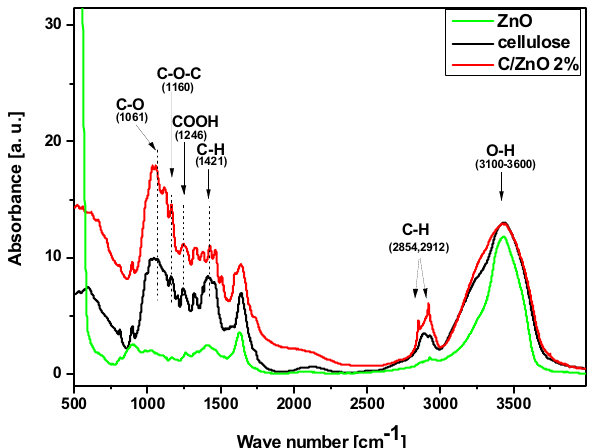
Figure 6. FTIR spectra of ZnO nanoparticles (green curve), cellulose fibers before (black curve) and after (red curve) the functionalization with ZnO particles.